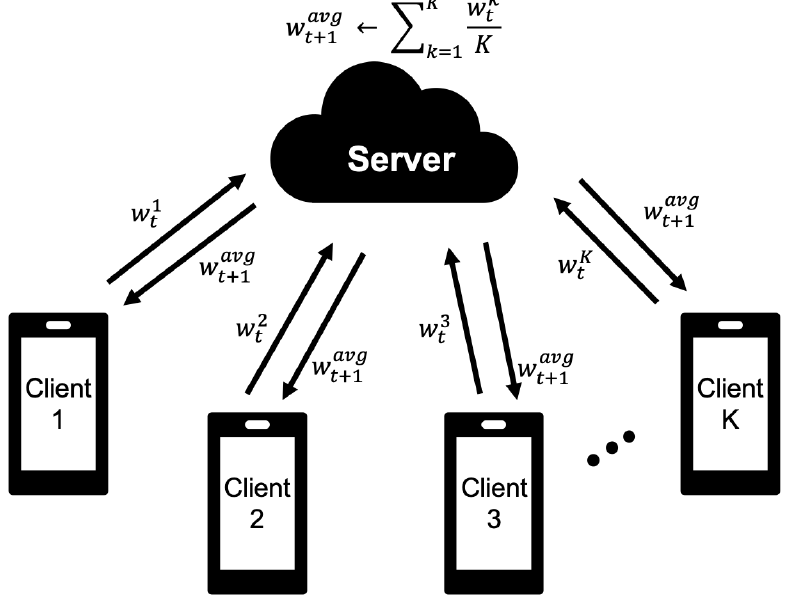
Figure 2. The weighted aggregation process of Federated Learning (such as FedAvg ) obtains the average of the w t value received from the client of K from the server and sends the updated w t + 1 back to the